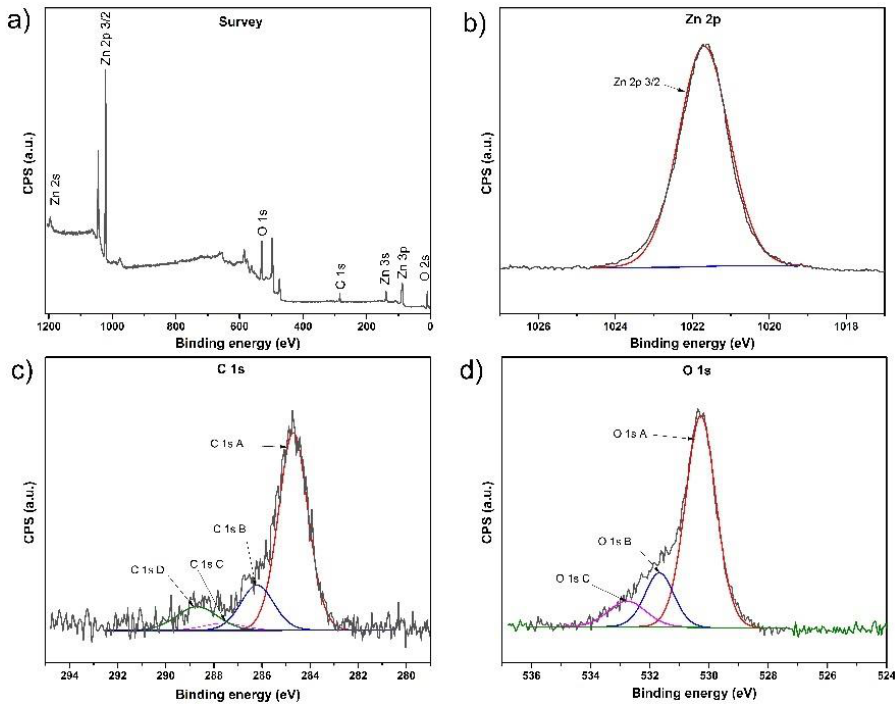
Figure 5. X-ray photoelectron spectroscopy spectra of 0.5%Fe-ZnO-40%CAC: ( a ) survey spectra, ( b ) Zn 2p spectra, ( c ) C 1s spectra, ( d ) O 1s spectra.